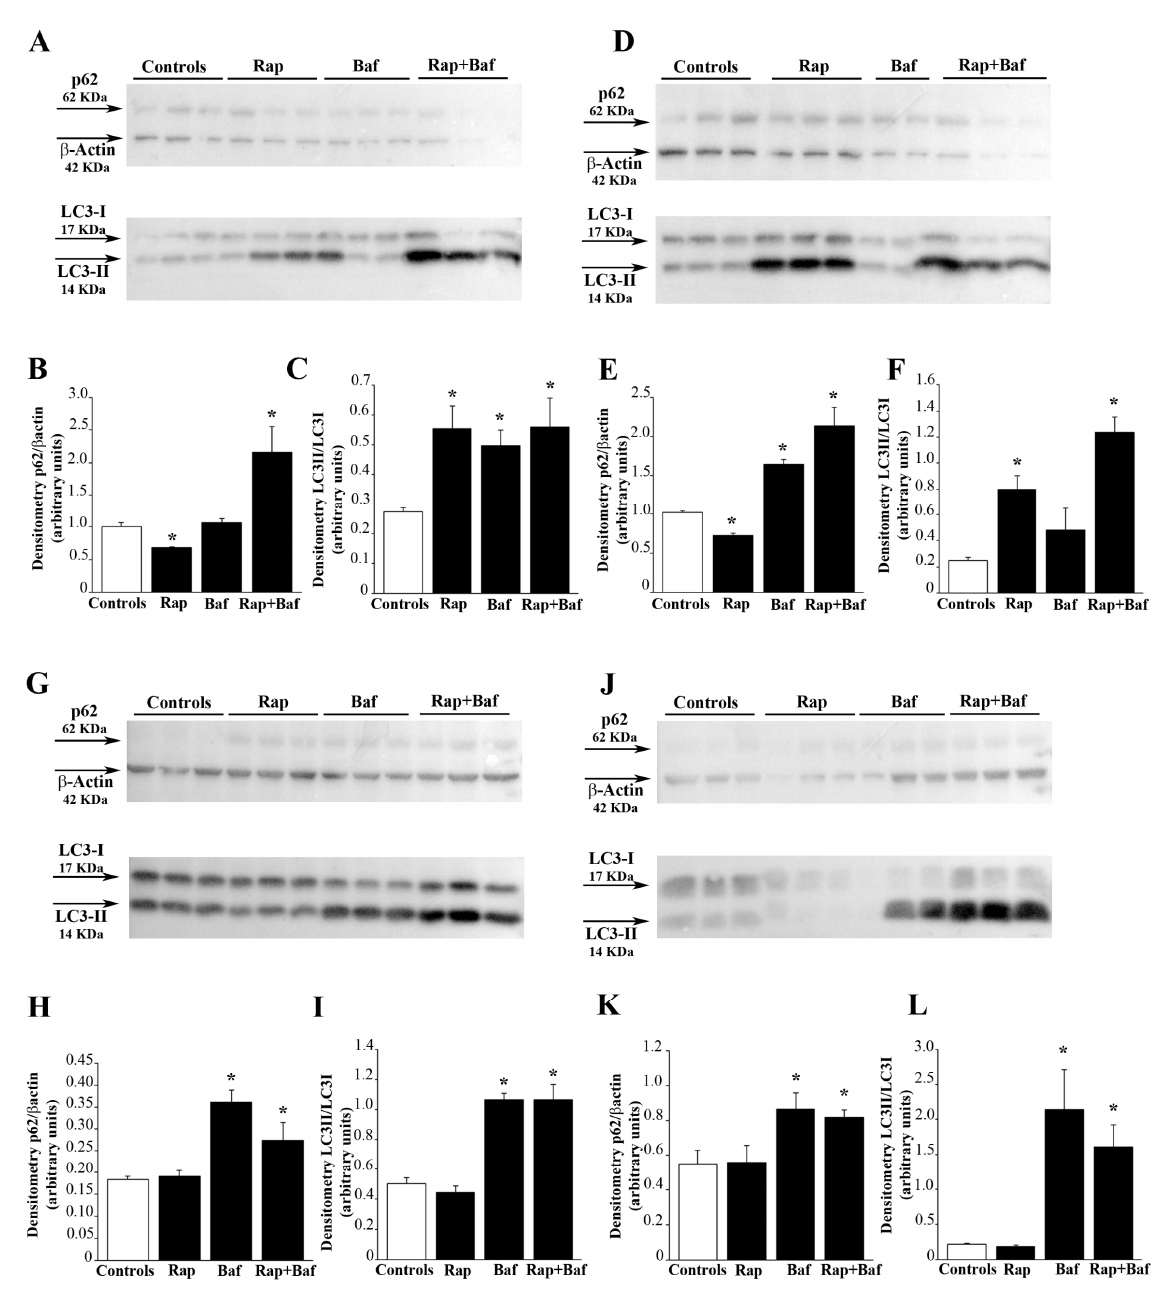
Figure 2. Rapamycin treatment increases the autophagy flux. Western blot analysis of p62 and LC3-II in U87MG cells treated with 10 nM rapamycin for ( A ) 24 h and ( D ) 4 d, ( G ) 7 d and ( J ) 14 d after its removal. In some samples bafilomycin A1 (100 nM) was added during the last 3 h in both untreated and rapamycin-treated cultures. Densitometry analysis of the level of p62 compared with the housekeeping β -actin and LC3-II compared with LC3-I is also reported in the graphs. In detail, densitometry of p62/ β -actin in cells treated with rapamycin for ( B ) 24 h and ( E ) 4 d, ( H ) 7 d and ( K ) 14 d after its removal is reported. Similarly, densitometry of LC3-II/LC3-I in cells treated with rapamycin for ( C ) 24 h and ( F ) 4 d, ( I ) 7 d and ( L ) 14 d after its removal is shown. Values are given as the mean ± SEM from three samples per experimental group. * p < 0.05 compared with controls.